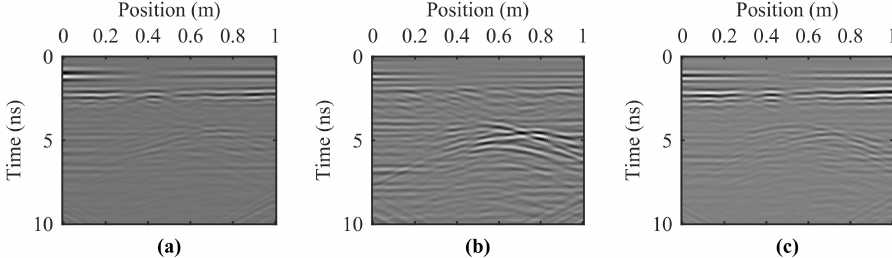
Figure 10. Full polarimetric data of metallic multibranch. (a) HH polarization. (b) HV polarization. (c) VV polarization.